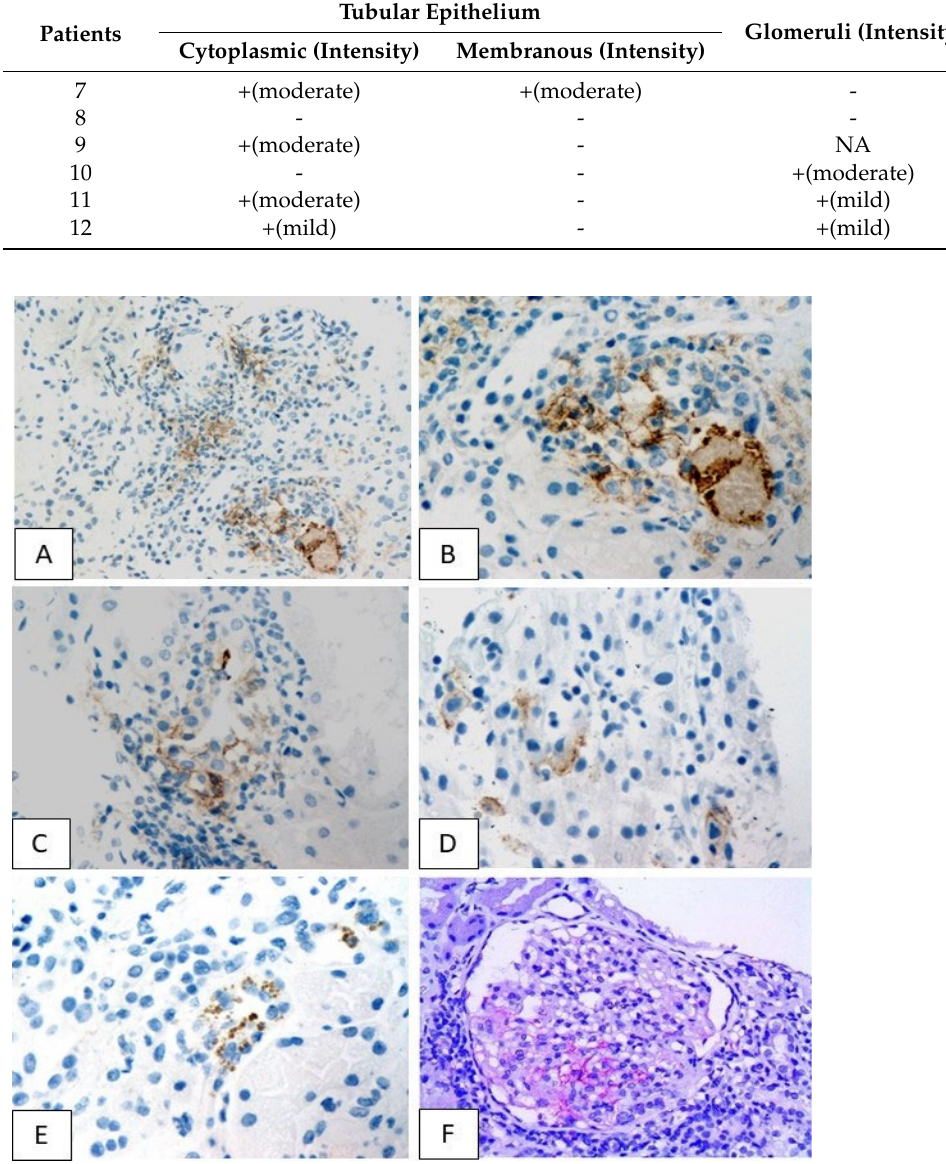
Figure 6 . Tubular PD ‐ L1 staining was either membranous (( A ): 200×, ( B – D ): 400×) or cytoplasmic Figure 6. Tubular PD-L1 staining was either membranous (( A ): 200 × , ( B – D ): 400 × ) or cytoplasmic (( E ): 400×). Glomerular PD ‐ L1 expression was detected in a few cases (( F ): 400×). (( E ): 400 × ). Glomerular PD-L1 expression was detected in a few cases (( F ): 400 ×